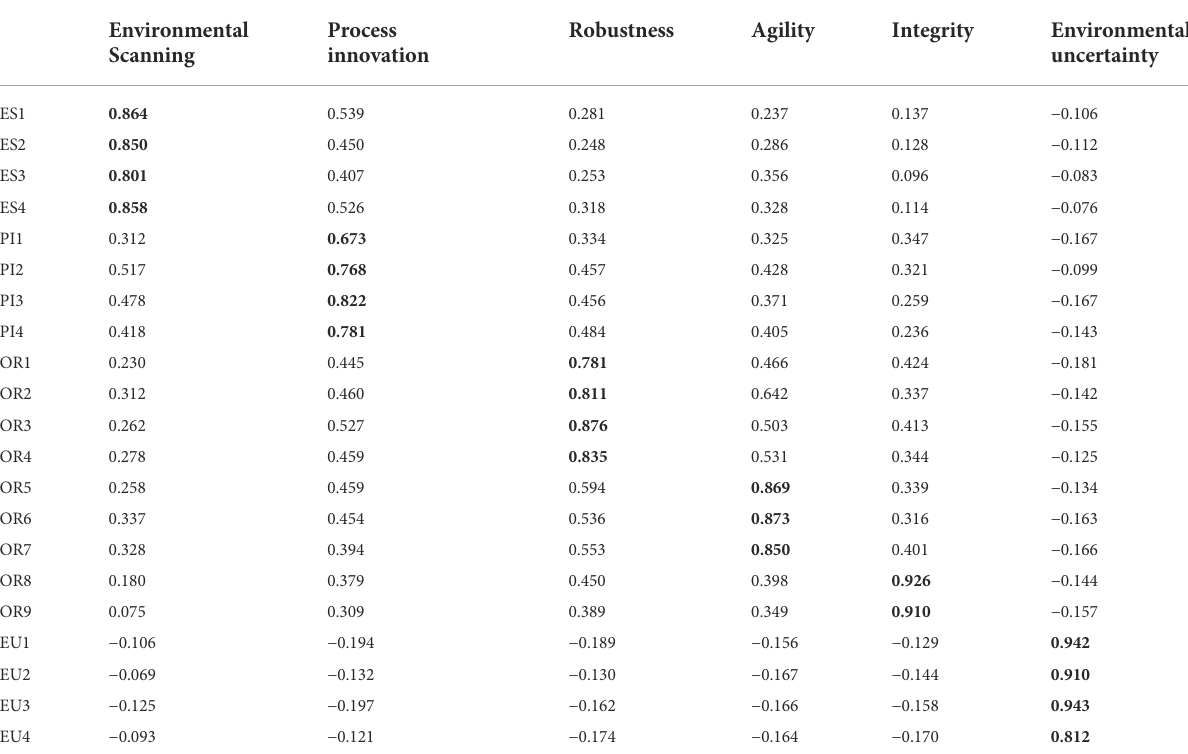
TABLE 3 Cross loadings of individual